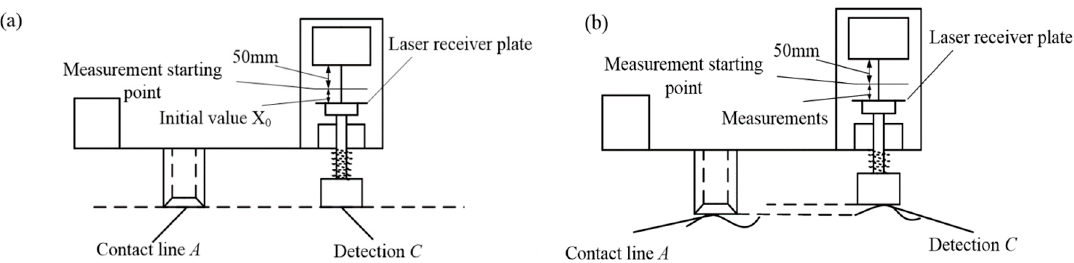
Figure 4. The positional relation between contact line A and detection line C : ( a ). Contact line A and detection line C are collinear; ( b ). Contact line A and detection line C are not collinear.